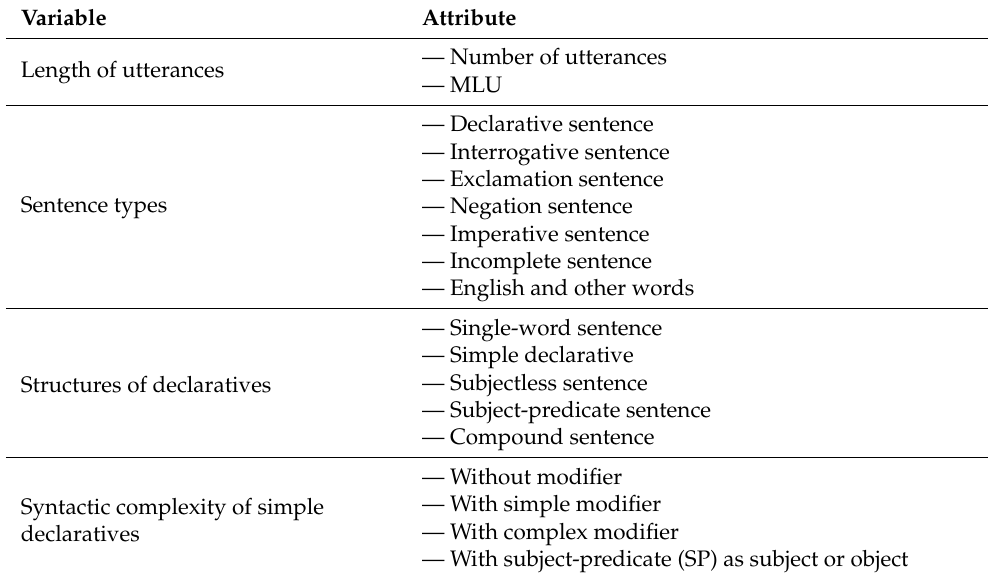
Table A1. The Framework of Syntactic Analysis proposed by Tse and Li